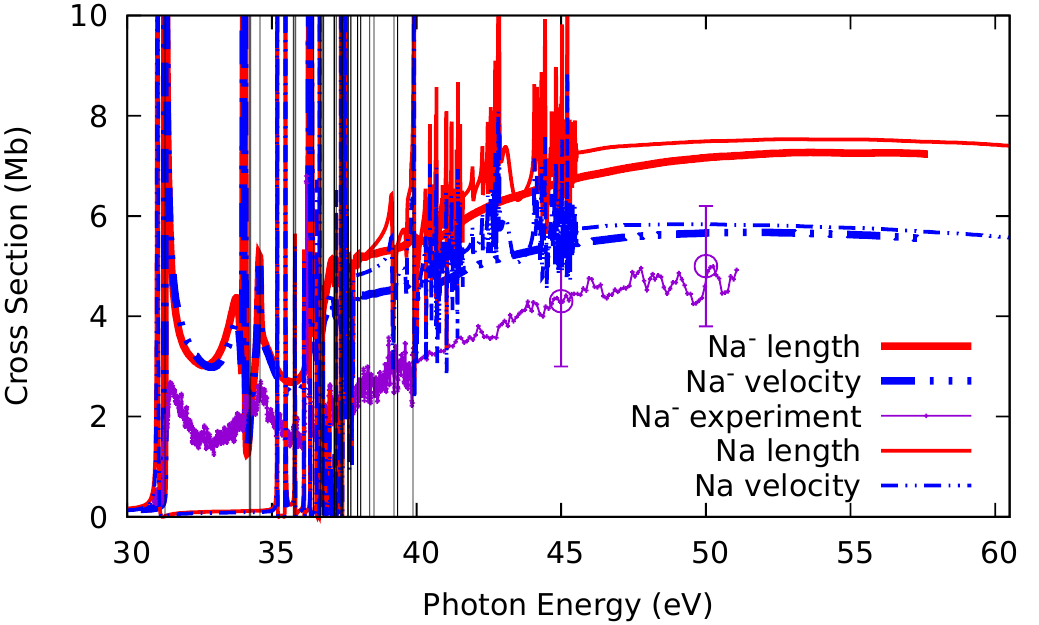
Figure 2. Present R-matrix Na photoionization cross sections compared to present R-matrix Na − photodetachment cross sections, in length and velocity gauges. The calculated inner-shell thresholds are shown as vertical black